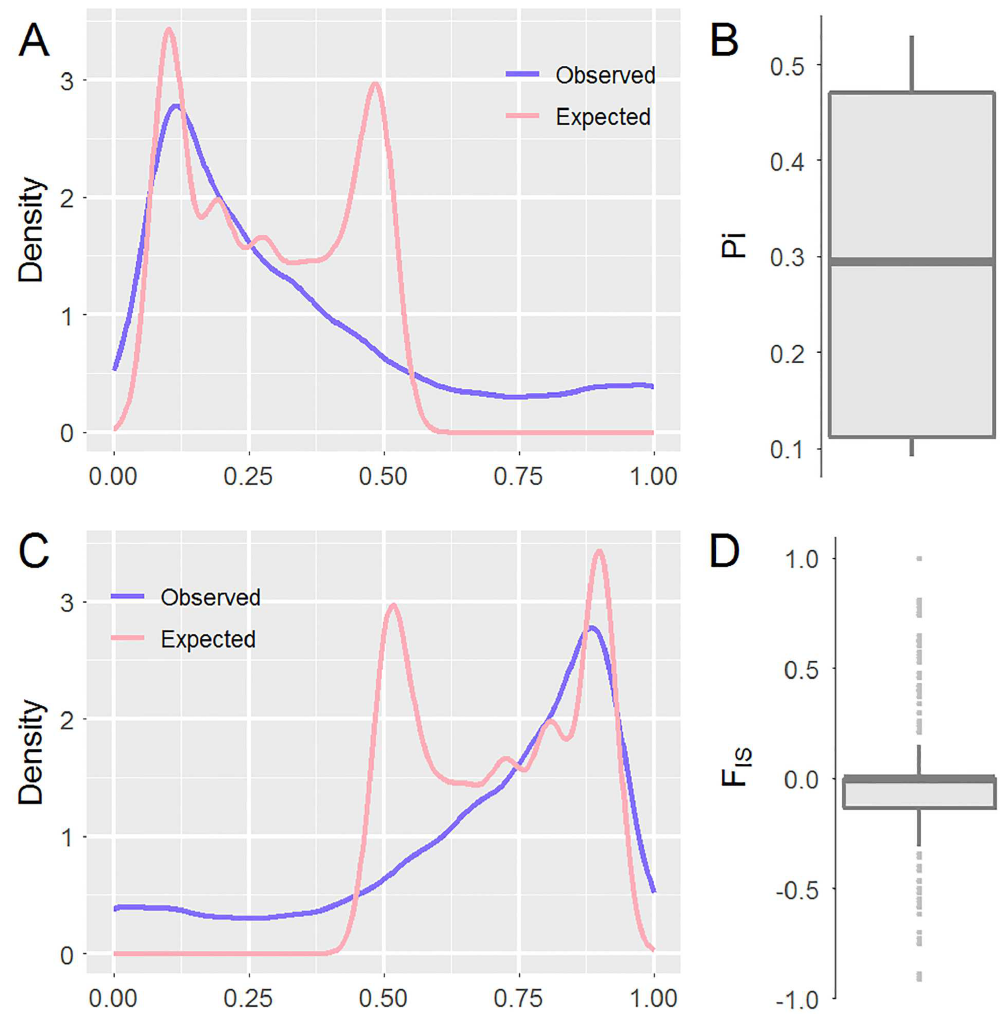
Fig 3. Distributions of the observed and expectedheterozygosity in density (A) and box (B) plots and for the observed and expected homozygosities (C and D).